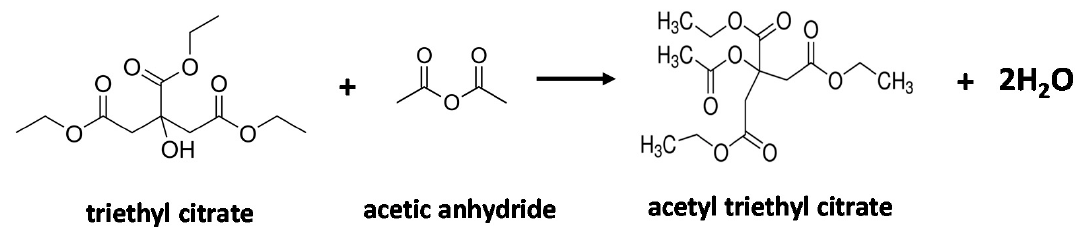
Figure 5. Reaction pathway of the acetylation of triethyl citrate (TEC) with acetic anhydride.